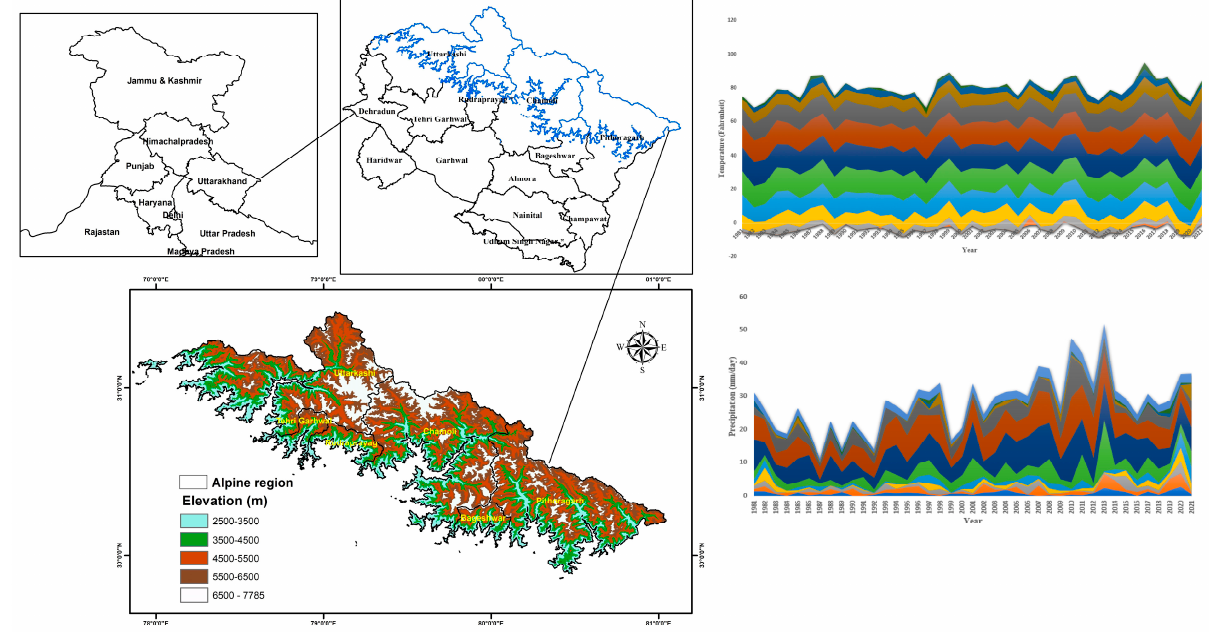
Figure 1. Study area map with decadal climatic data (Temperature, Precipitation).